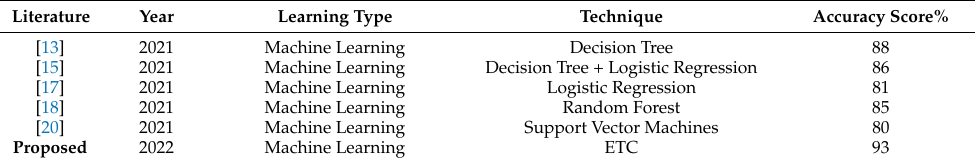
Table 7. The performance validation comparative analysis of our proposed approach with the past applied state of art approaches.